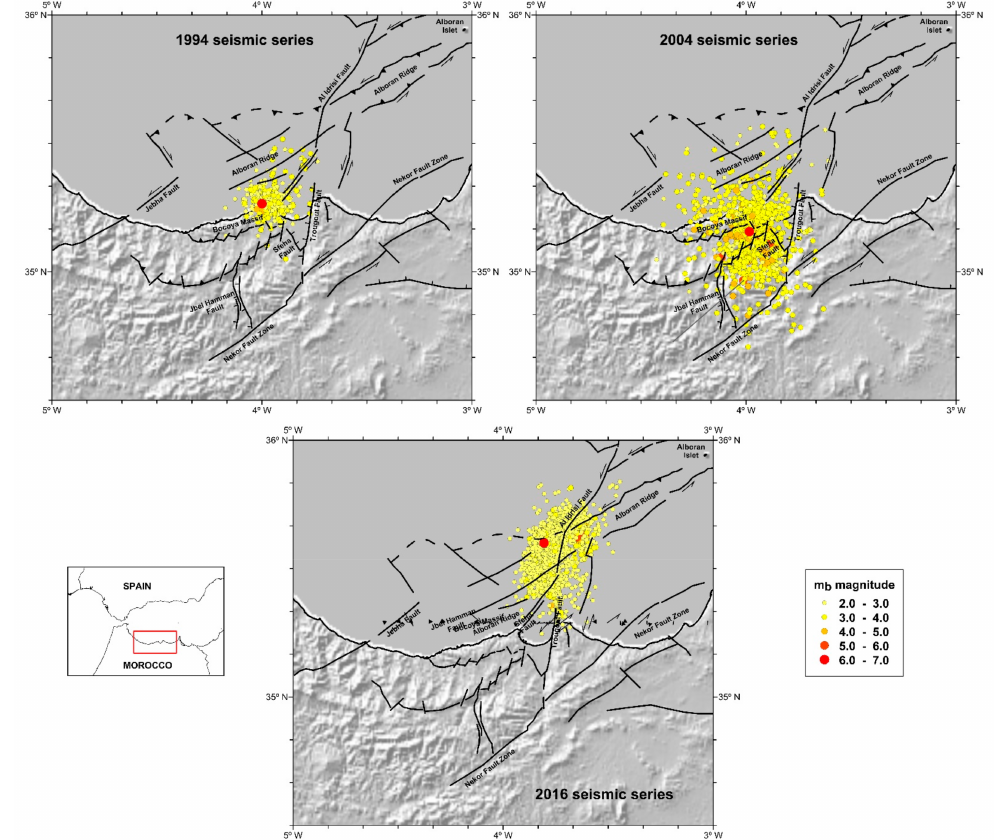
Figure 2. Seismicity recorded by the Spanish IGN included in the 1994, 2004 and 2016 seismic series from magnitude 2.0. Main tectonic features are